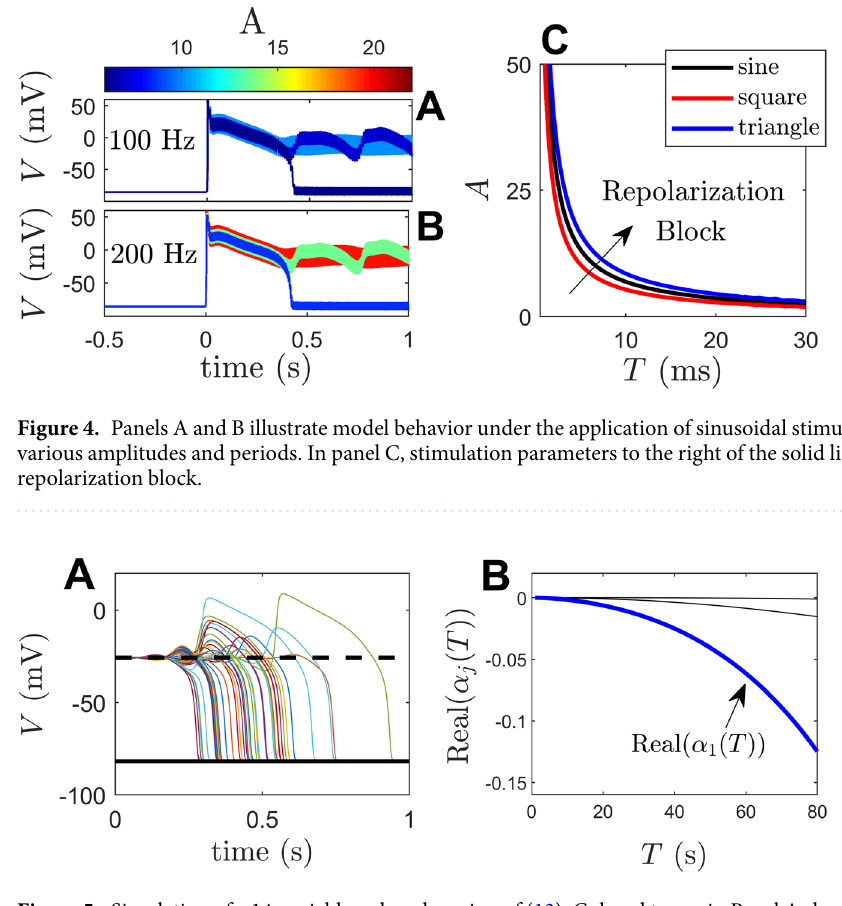
Figure 5. Simulation of a 14-variable reduced version of (13). Colored traces in Panel A show simulations with initial conditions near an unstable fixed point. The dashed (resp., solid) black line shows a simulation where the initial condition is taken to be the unstable (resp., stable) fixed point. Panel B shows the curves Real( α j ( T )) from (3) calculated numerically corresponding to the first four eigenvalues of the unstable fixed point (here α 1 and α 2 are